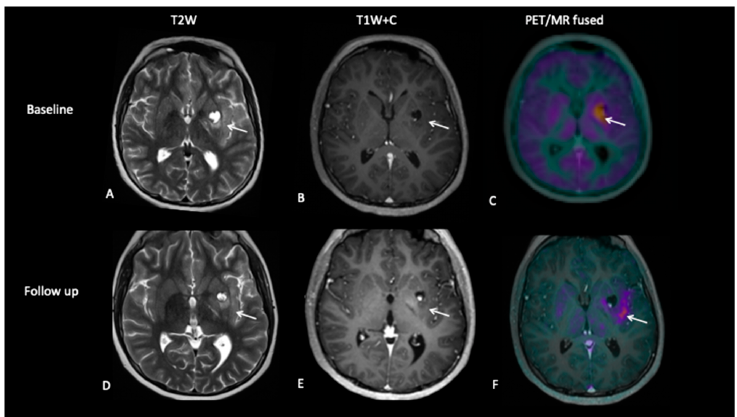
Figure 5. At baseline, there is non-enhancing tumour involving the left basal ganglia ( A,B ) with 8 F- fluorocholine (FCho) and 18 fluoro-L-phenylalanine (FDOPA) avidity ( C ). Follow-up imaging